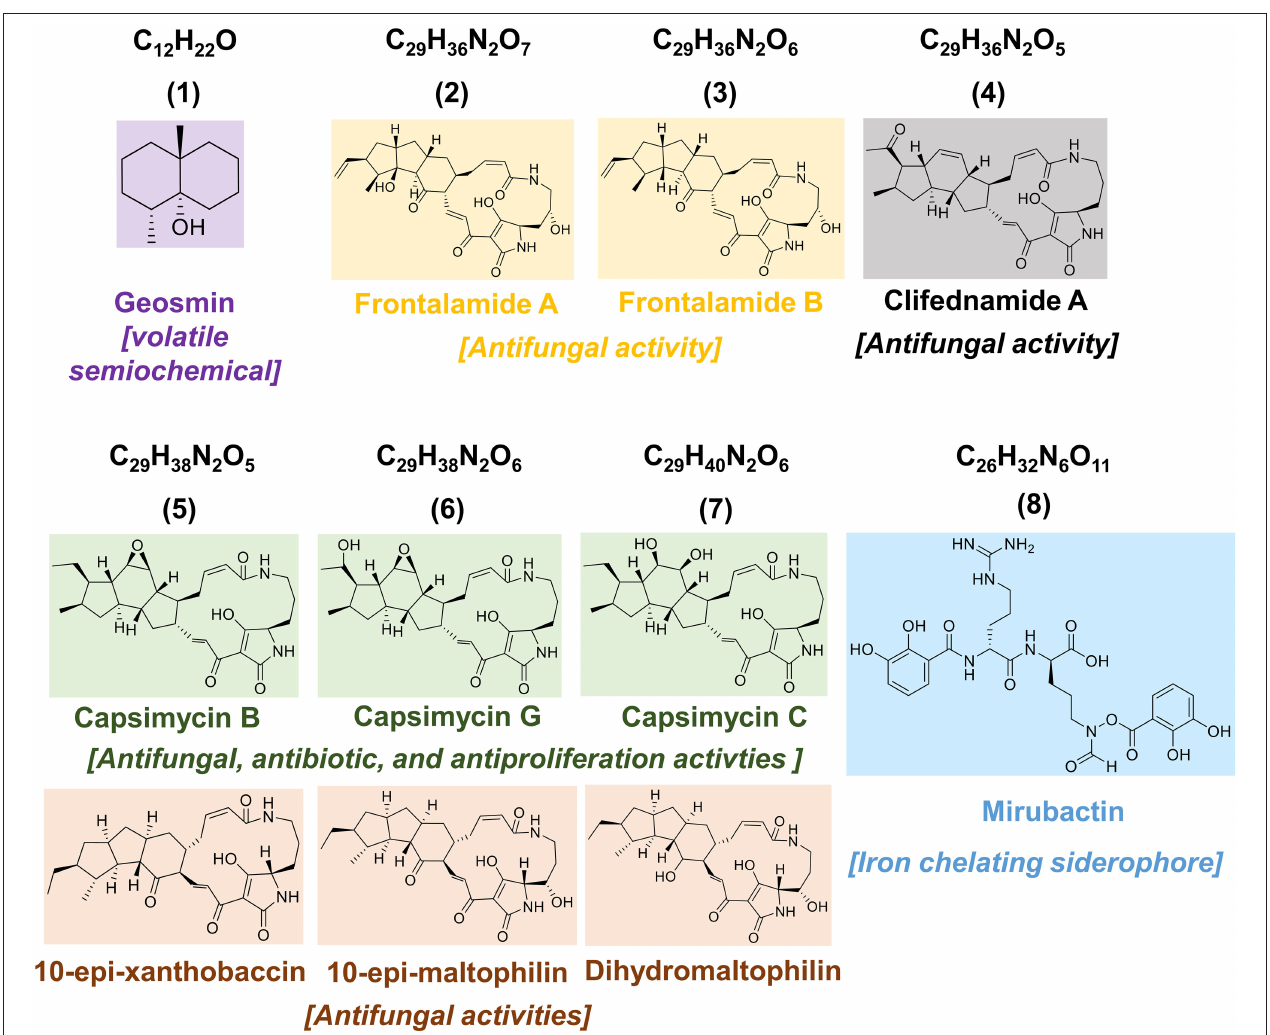
FIGURE 3 | Chemical structures of the compounds detected in the present